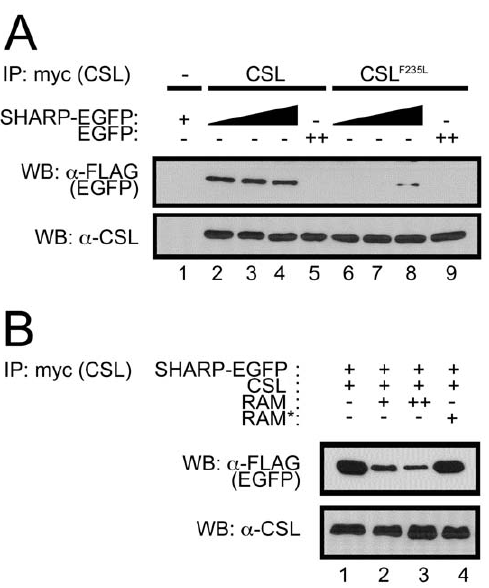
Figure 5. CSL F235L and RAM both perturb the interaction with the co-repressor SHARP. A). Immunoprecipitation of the co- repressor SHARP with CSL, and disruption by F235L point substitution. After co-transfection of HeLa cells with SHARP-EGFP (3xFLAG) and CSL (myc), SHARP-EGFP is readily detected by immunoprecipitation of wild- type CSL (lanes 2–4); no interaction is detected between CSL and EGFP- 3xFLAG (lane 5). SHARP-EGFP is only weakly detected at the highest concentration after immunoprecipitation of CSL F235L (lanes 6–8); no interaction is detected between CSL F235L and EGFP-3xFLAG (lane 9), directly demonstrating that the F235L point substitution perturbs co- repressor binding. B). Disruption of SHARP:CSL immunoprecipitation with binding competent RAM. The interaction between CSL and SHARP is perturbed with increasing amounts of RAM peptide, but is unaffected by RAM* peptide (CSL-binding incompetent peptide), demonstrating that RAM directly displaces co-repressor protein(s).